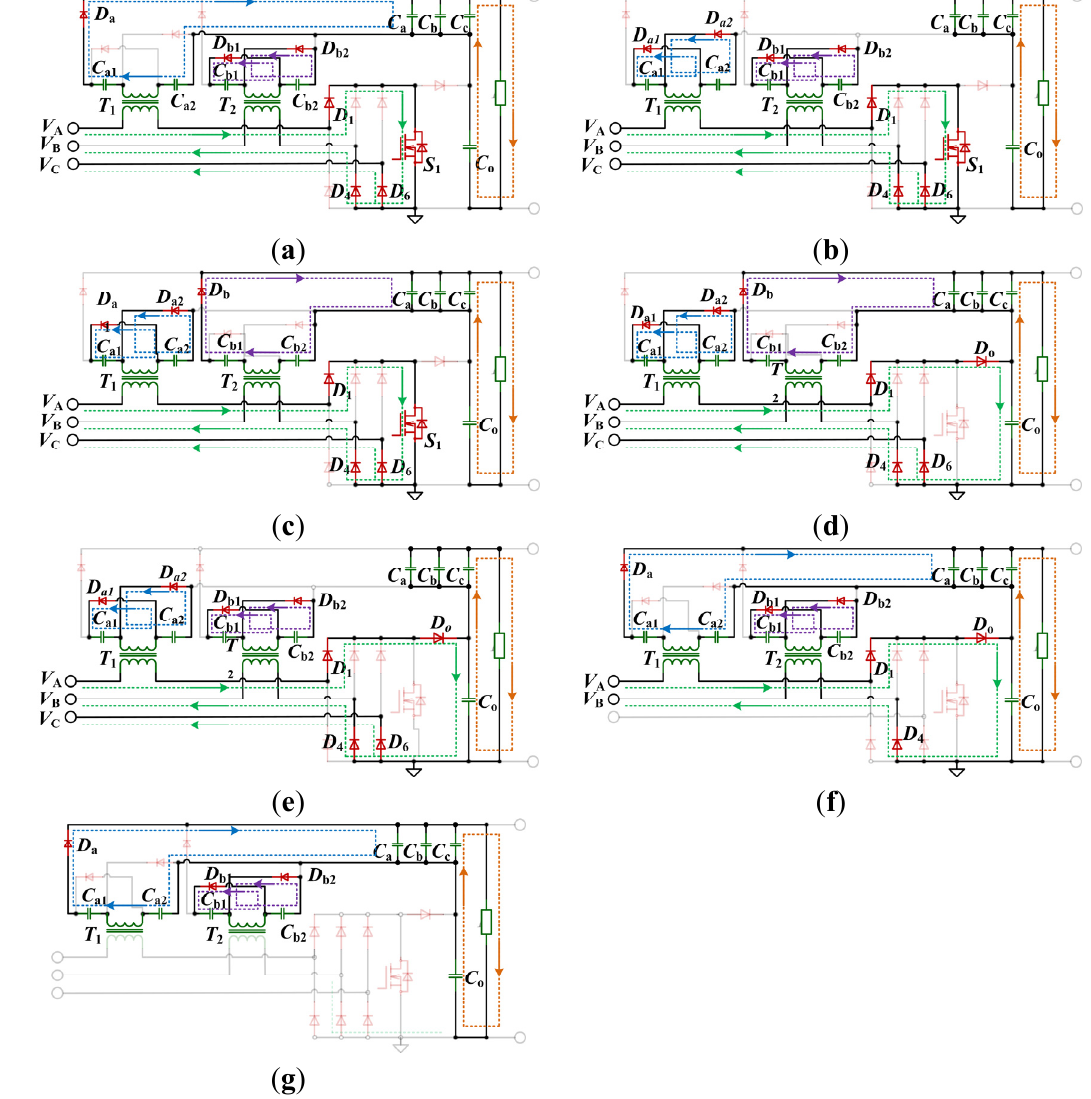
Figure 12. Equivalent circuits. ( a ) mode I; ( b ) mode II; ( c ) mode III; ( d ) mode IV; ( e ) mode V; ( f ) mode VI; ( g ) mode